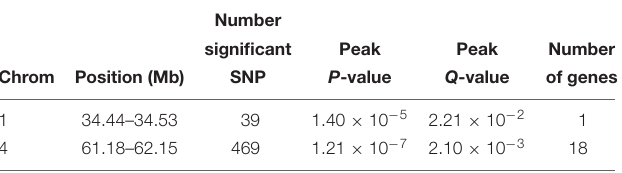
TABLE 3 | Putative selection signatures identified across Sri Lanka ecotypes in the hapFLK analysis.